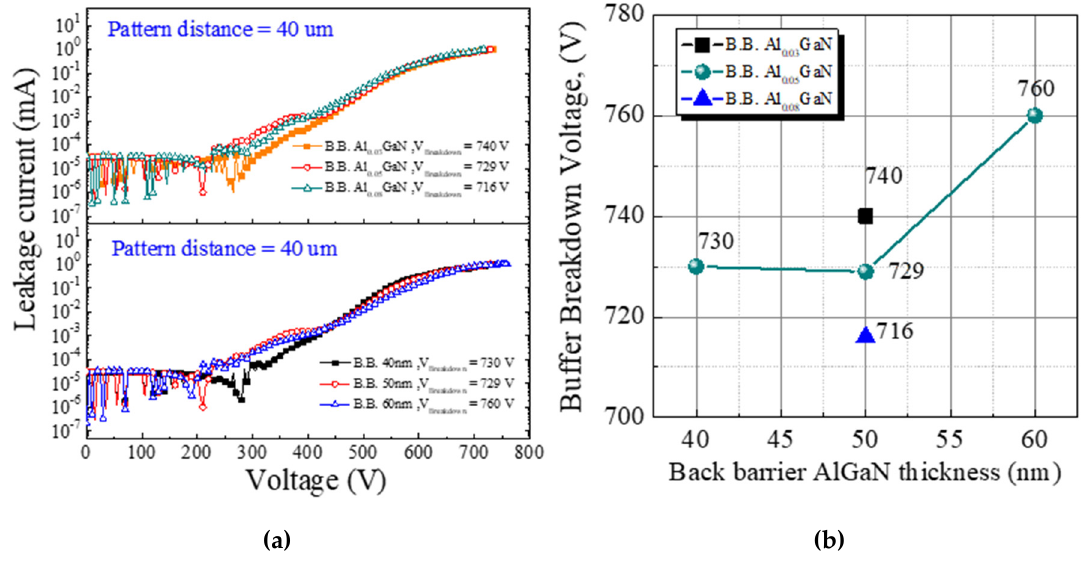
Figure 5. The horizontal breakdown characteristics of devices. ( a ) The leakage current versus voltage of devices; ( b ) The buffer breakdown voltage of the devices.